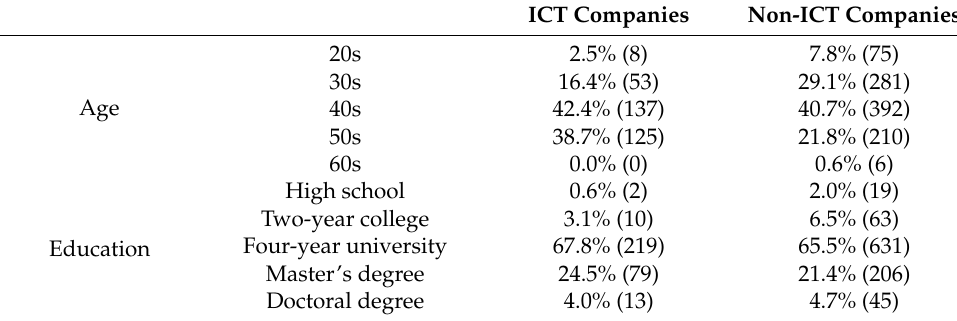
Table 2. Respondents’ descriptive